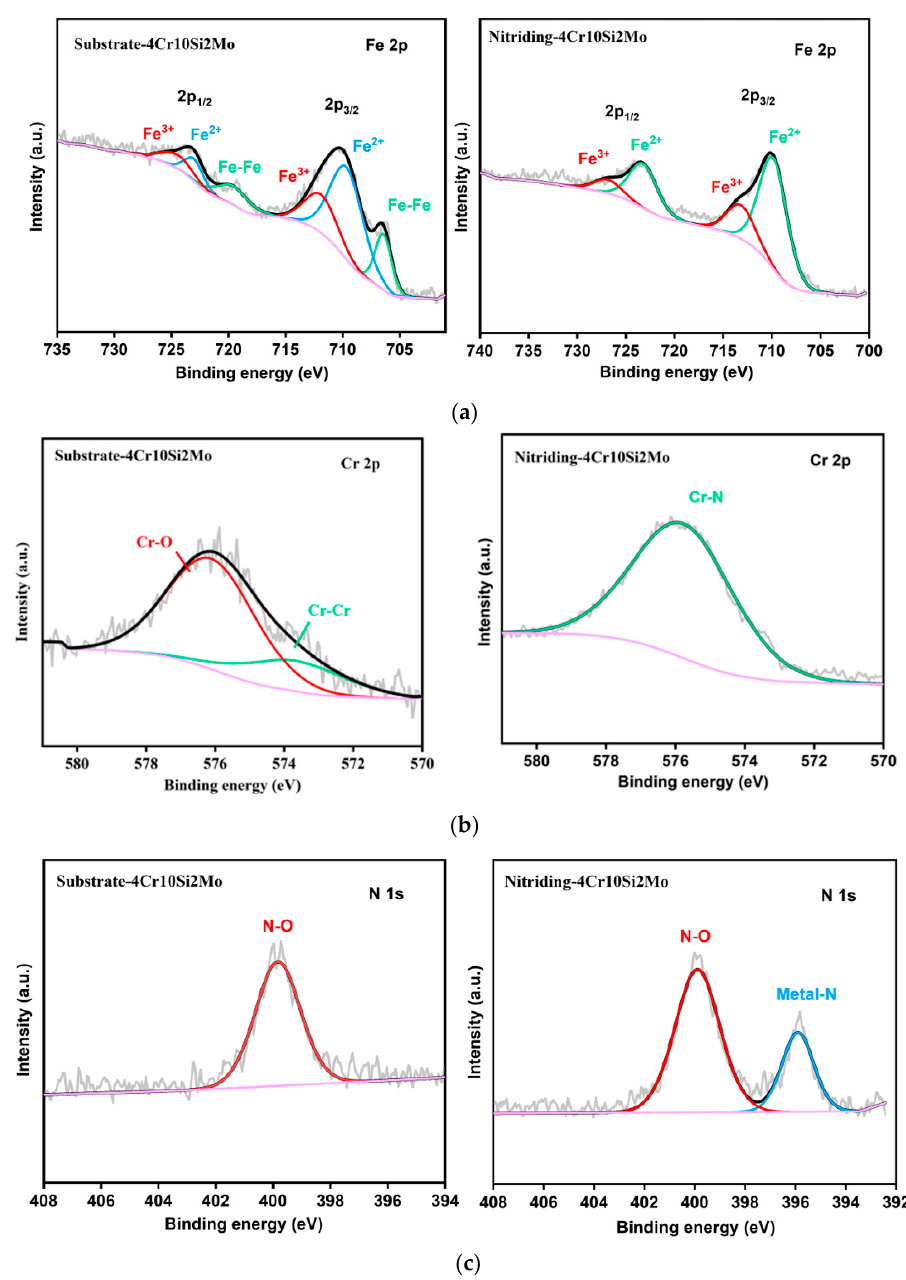
Figure 7. Substrate 4Cr10Si2Mo and nitrided 4Cr10Si2Mo element XPS fine spectrum. ( a ) Fine spectrum of surface Fe before and after nitriding. ( b ) Fine spectrum of surface Cr before and after nitriding. ( c ) Fine spectrum of surface N before and after nitriding.